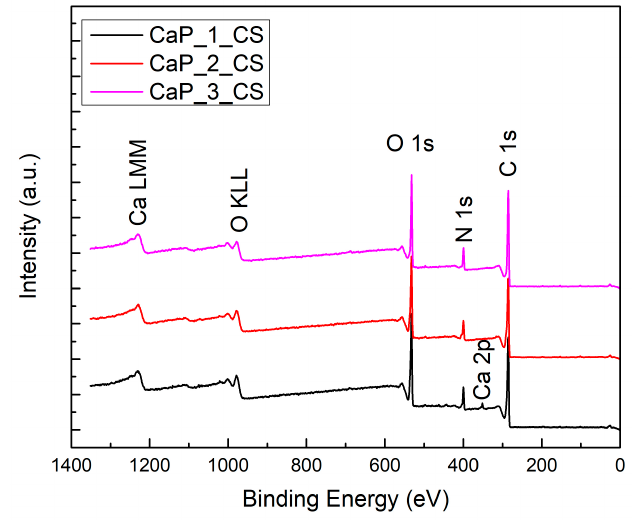
Figure 5. XPS survey spectra of CaP_CS coatings. Table 2. XPS binding energies (eV) for the CaP_CS